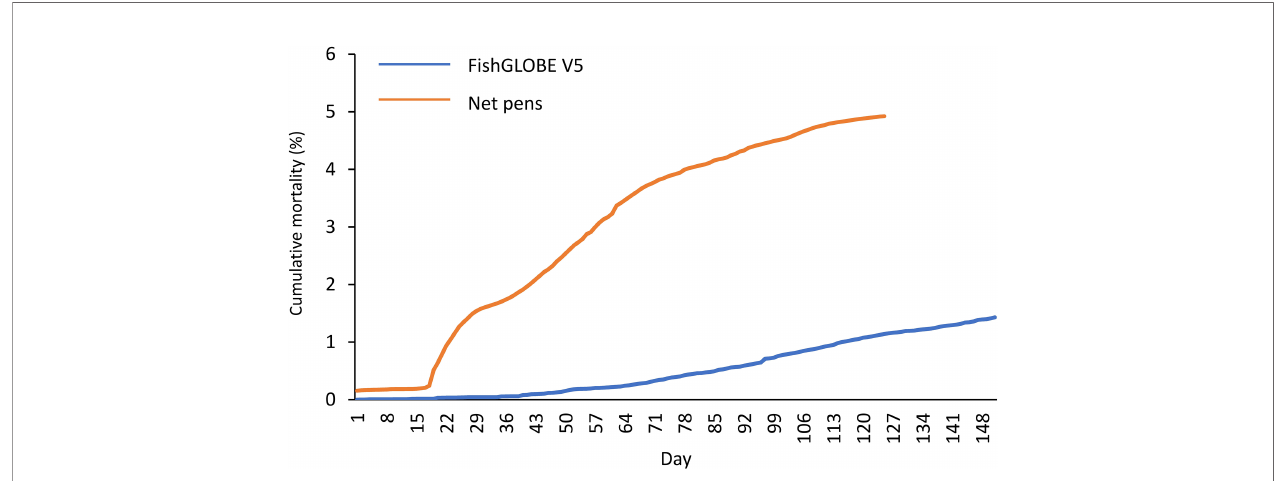
FIGURE 2 | Fish mortality. Cumulative mortality (%) in FishGLOBE V5 (blue line) and three months after release to net pens (orange line). Registrations of dead fi sh continued after the S3 sampling was carried out in